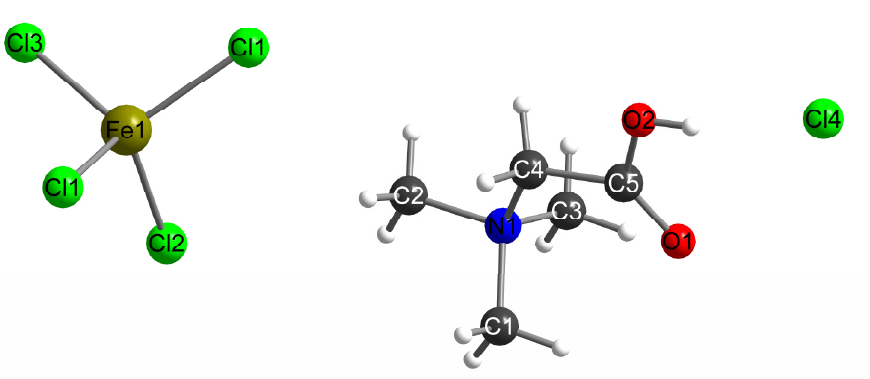
Figure 1. Asymmetric unit of the crystal structure of (Hbet) numbering